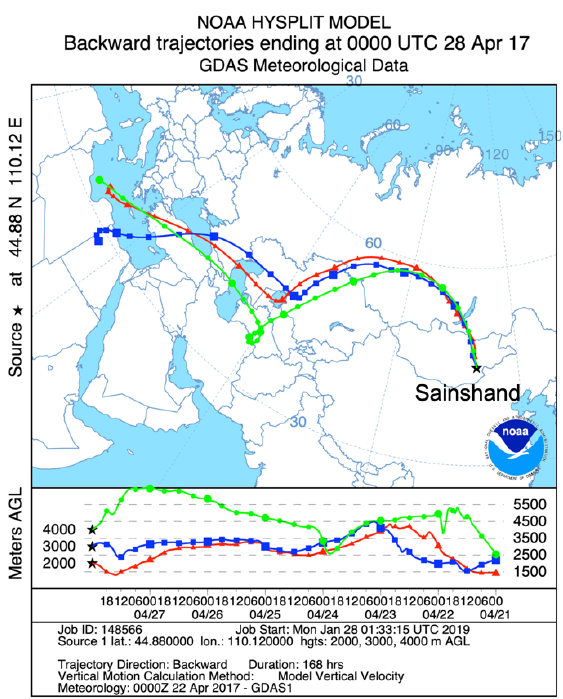
Fig.4 HYSPLIT backward trajectory of the Sahara dust plume indicated in Fig.